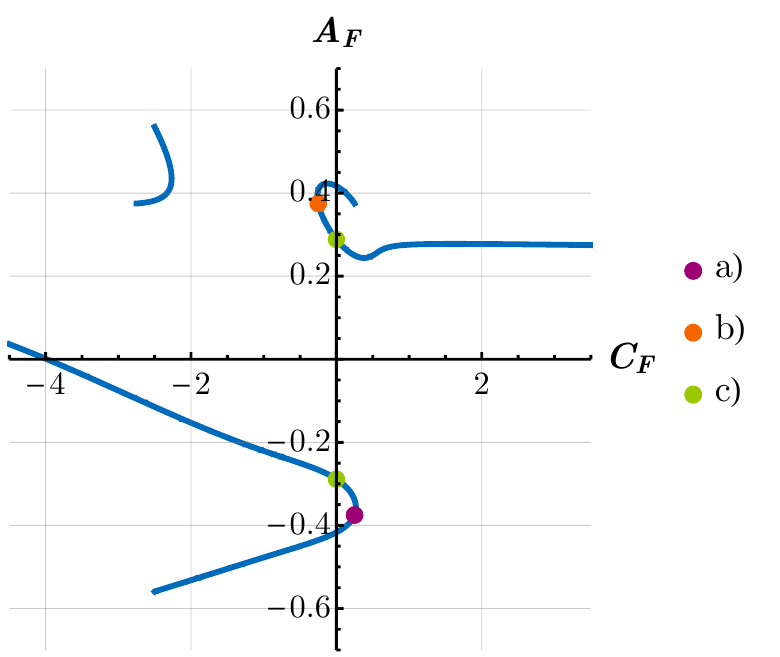
Figure 1 . Set of points that verify (4.35) (blue curve) and have E 2 correspond to the particular solutions (4.32). Both curves tend asymptotically to A F = 1 / 4 for C F → ±∞